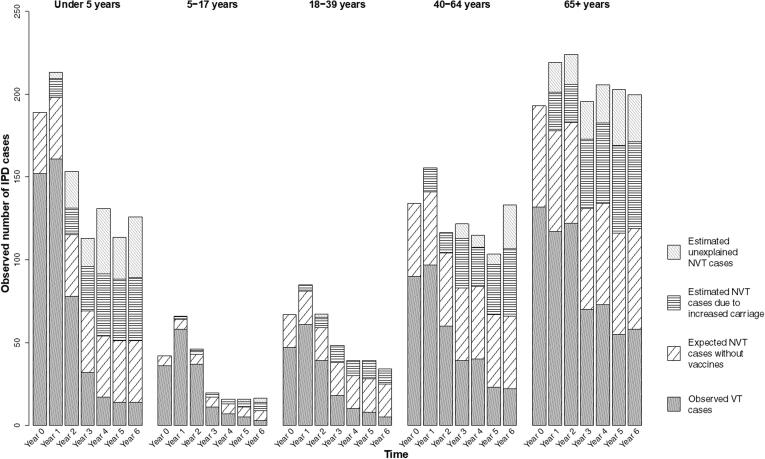
Estimated additional cases gained as a result of increased carriage in children under 5 in Israel, July 2009-July 2016. Results are shown for each age group and year of the study. Each full bar represents the total number of observed IPD cases for that stratum. The different patterned portions of the bars denote the fraction of total cases attributable to different groups of serotypes: observed vaccine-targeted (VT) serotype cases (solid gray), expected non-vaccine-targeted (NVT) serotype cases had PCV13 not been introduced (diagonal black lines), estimated additional cases gained as a result of increased carriage in children, explained by this model (horizontal black lines), and estimated additional cases gained that are not explained by this model (gray diagonal gray lines).